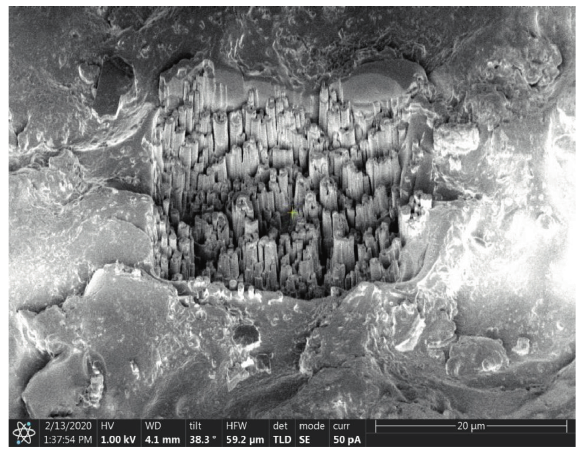
Figure 13: LR White milled with Xe + at